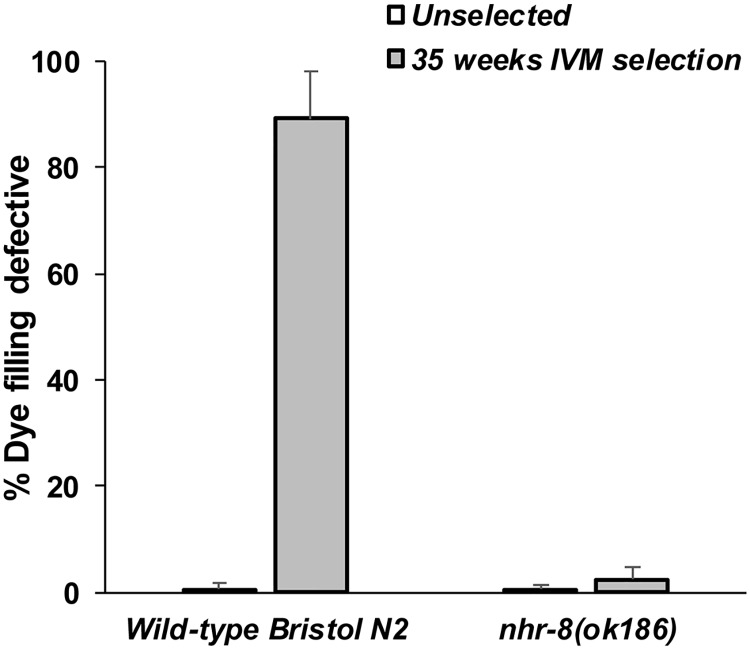
Percentage of C. elegans with dye-filling defective amphid neurons phenotype.Dye-filling of amphid neurons in the wild-type Bristol N2 strain and nhr-8(ok186) mutants was analysed before (unselected, white bar) and after a 35-weeks period of drug selection pressure with IVM (grey bar) (see Material & methods section for the drug selection process). Young adult worms were examined by fluorescence microscopy to visualize dye filling of the amphid dendrites after staining with the fluorescent dye DiIC12(3) (DiI) and scored for the dye filling (Dyf) defective phenotype (absence of red staining of the amphid neuron). Typical patterns of dye-filled amphidial dendrites from wild-type Bristol N2 worms and nhr-8(ok186) mutants are shown in S4 Fig.